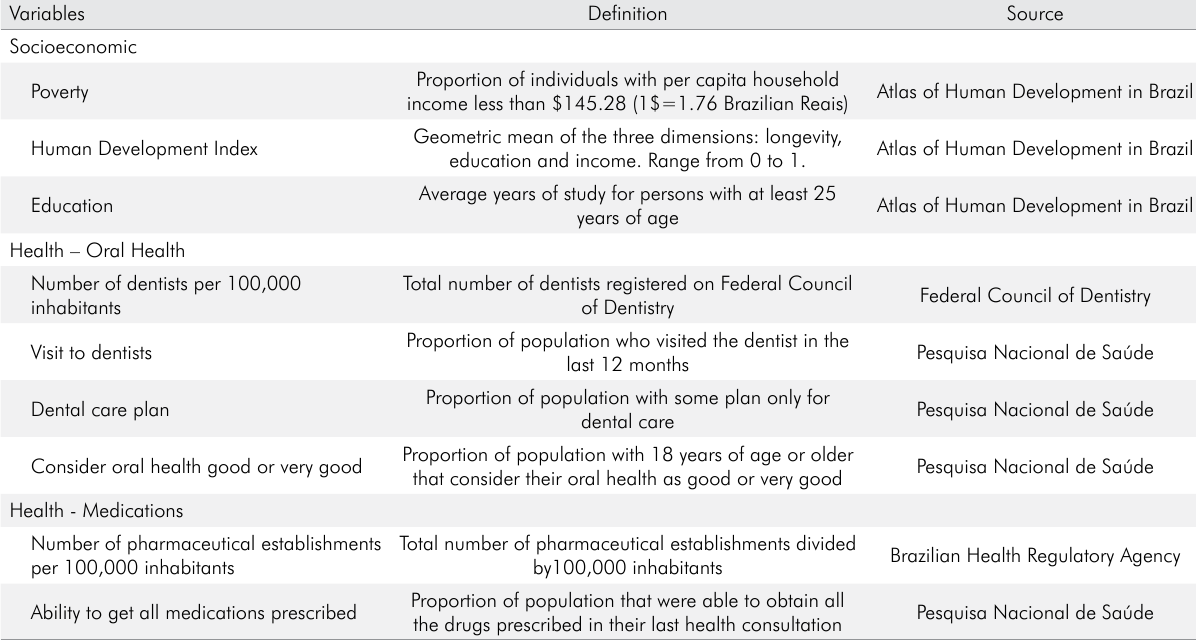
Table 1. List of